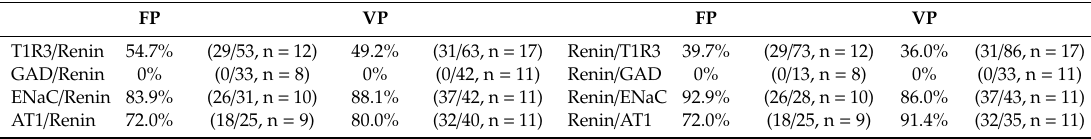
AT1: angiotensin II type 1 receptor; ENaC: epithelial sodium channel α -subunit; GAD: glutamate decarboxylase; T1R3: taste receptor type 1 member 3. The number of protein1 + protein2 doubly labeled cell / number of protein2 positive cell and n = number of taste buds examined are shown in parentheses.